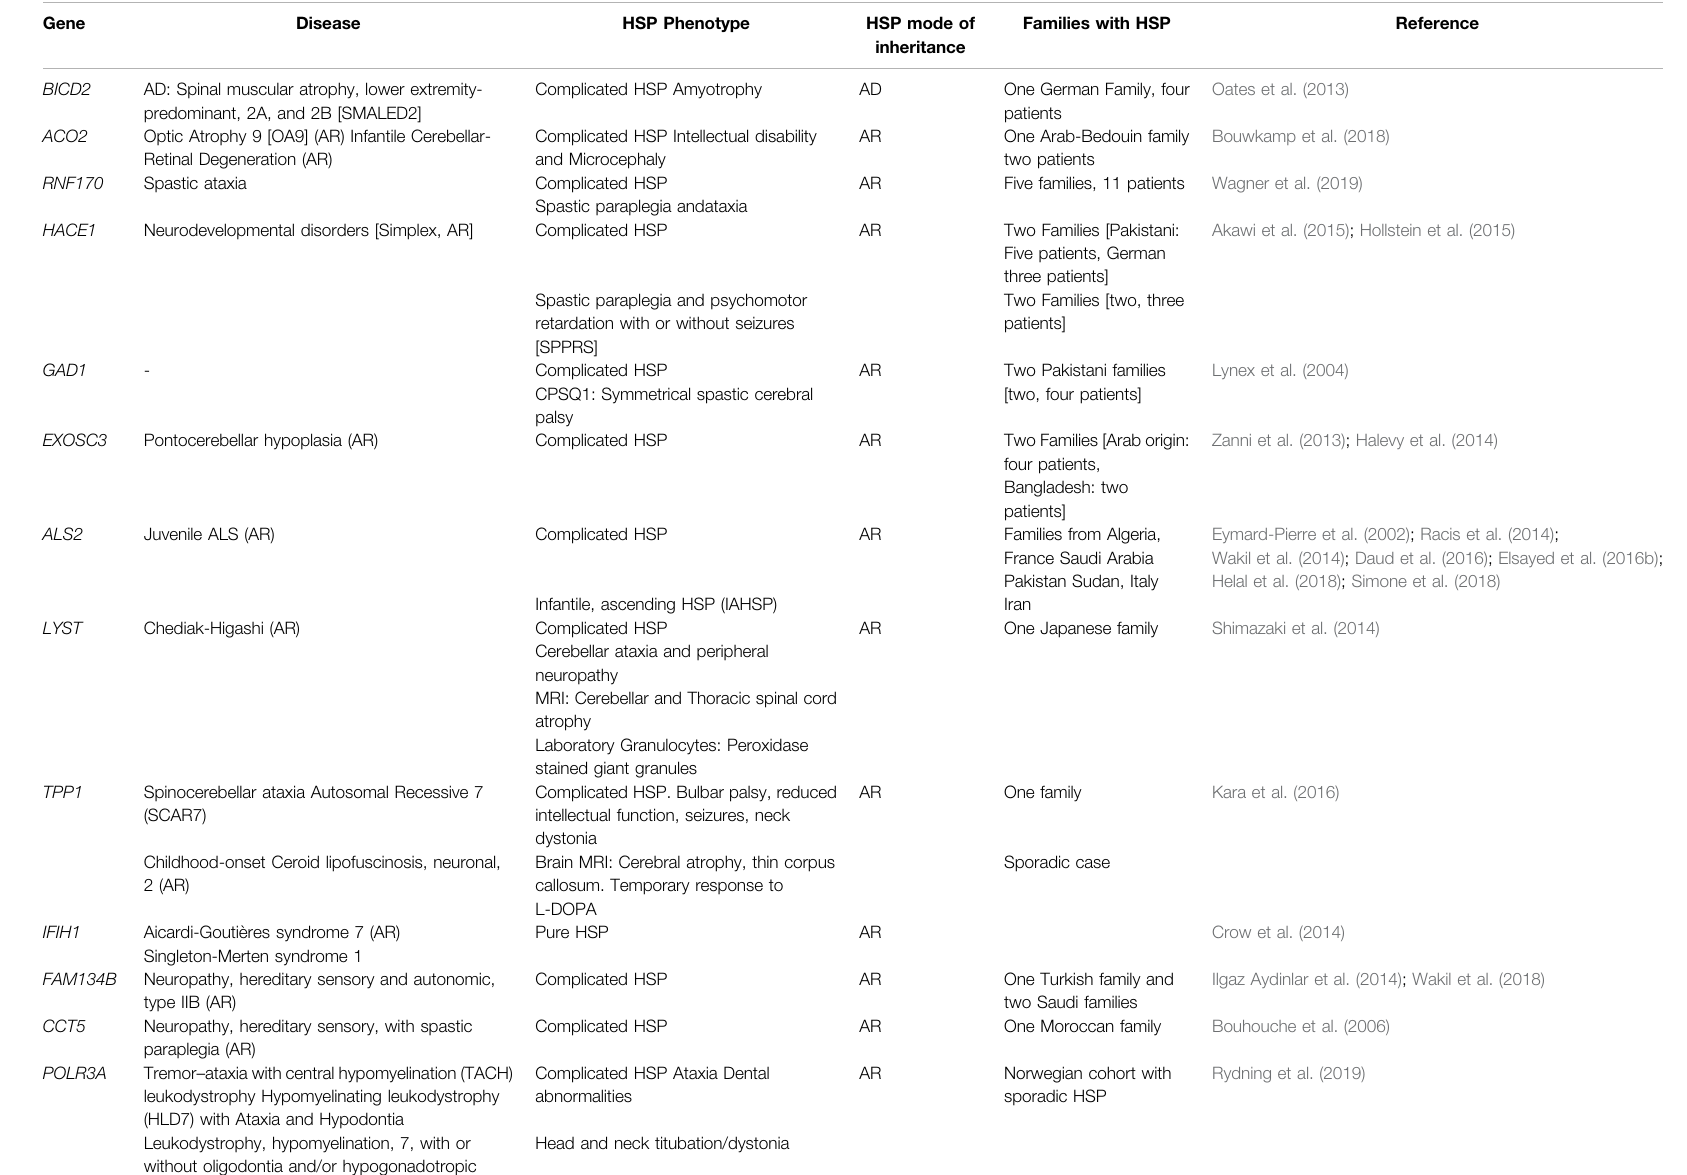
TABLE 1 | Table summarizing HSP forms associated with non-SPG genes and the main allelic phenotypes associated with causative variants in these